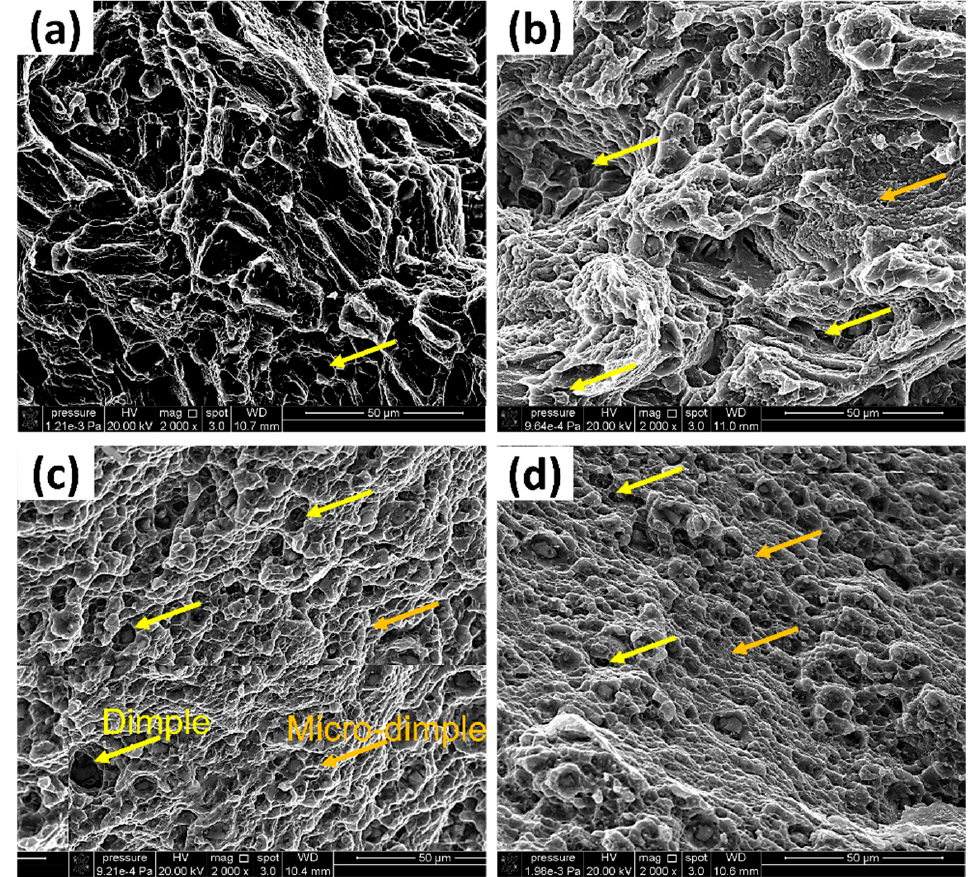
Figure 3. Tensile fractography morphologies of the AA5052 before and after the CEC process with different numbers of passes observed through scanning electron microscopy: ( a ) the initial annealed state, ( b ) the first pass, ( c ) the second pass, and ( d ) the fourth pass.